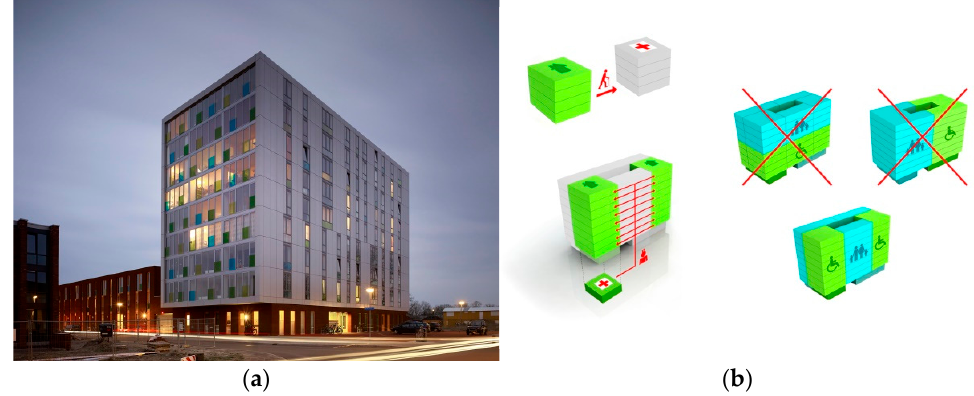
Figure 4. Hybrid apartment tower in Groningen, Netherlands ( a ) and diagram of integration of health, care, and housing within the apartment block ( b ). Photo: Christian Ritcher. Drawings: Casanova + Hernandez Arquitectos.